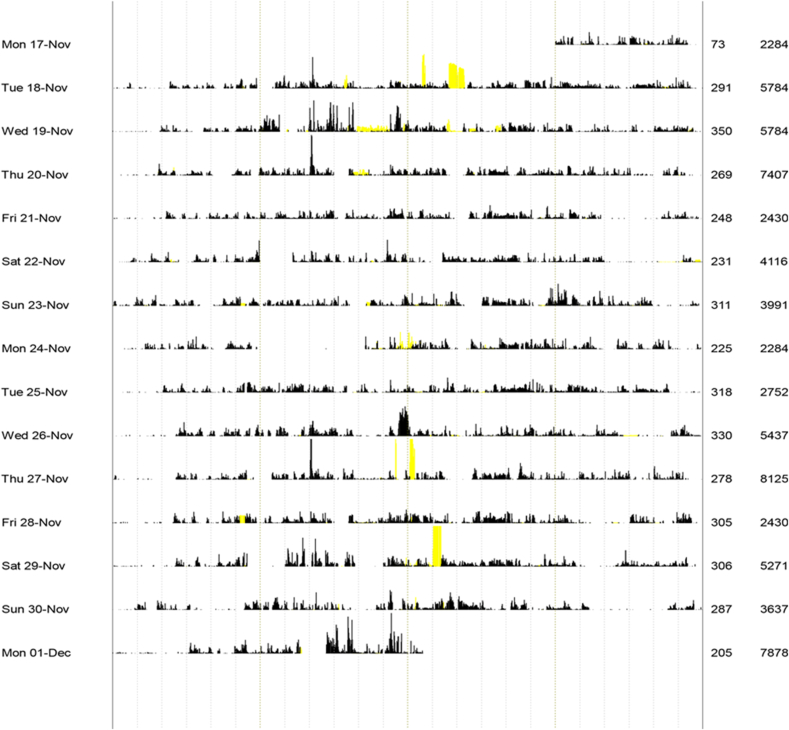
Example actogram.